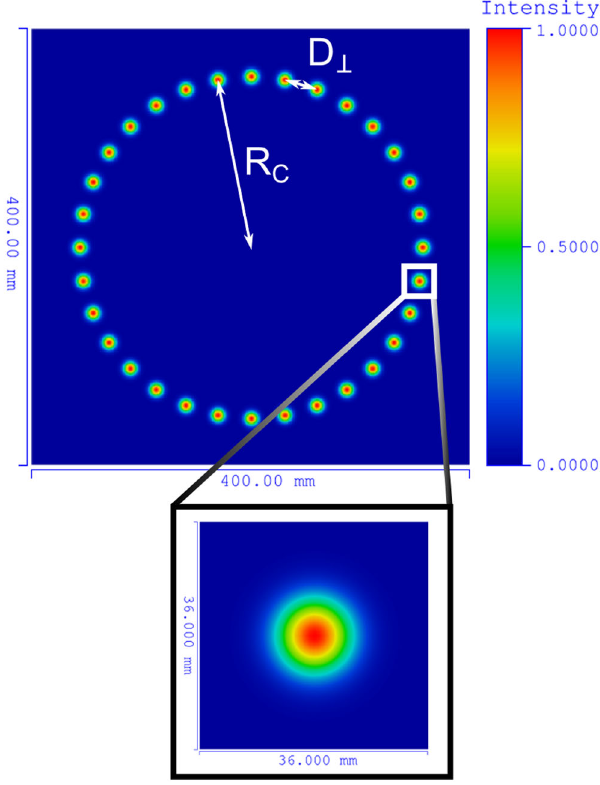
FIG. 4. Beam intensity profiles of the focusing parabolic mirror as computed by the C ODE V software. The intensity distribution of the last pass is zoomed and shown separately.